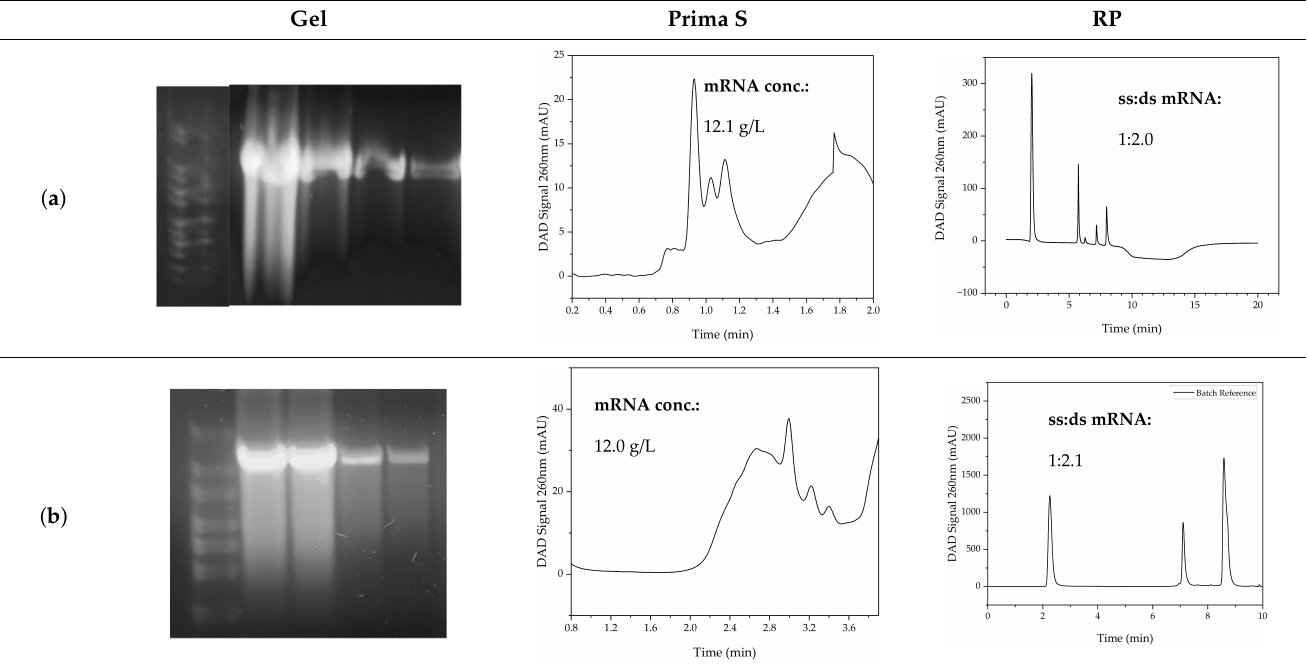
Table 6. Result of optimal operating point (OOP) predicted from DoE ( a ). Reproduction of OOP performed with ( c ) and without ( b ) cap